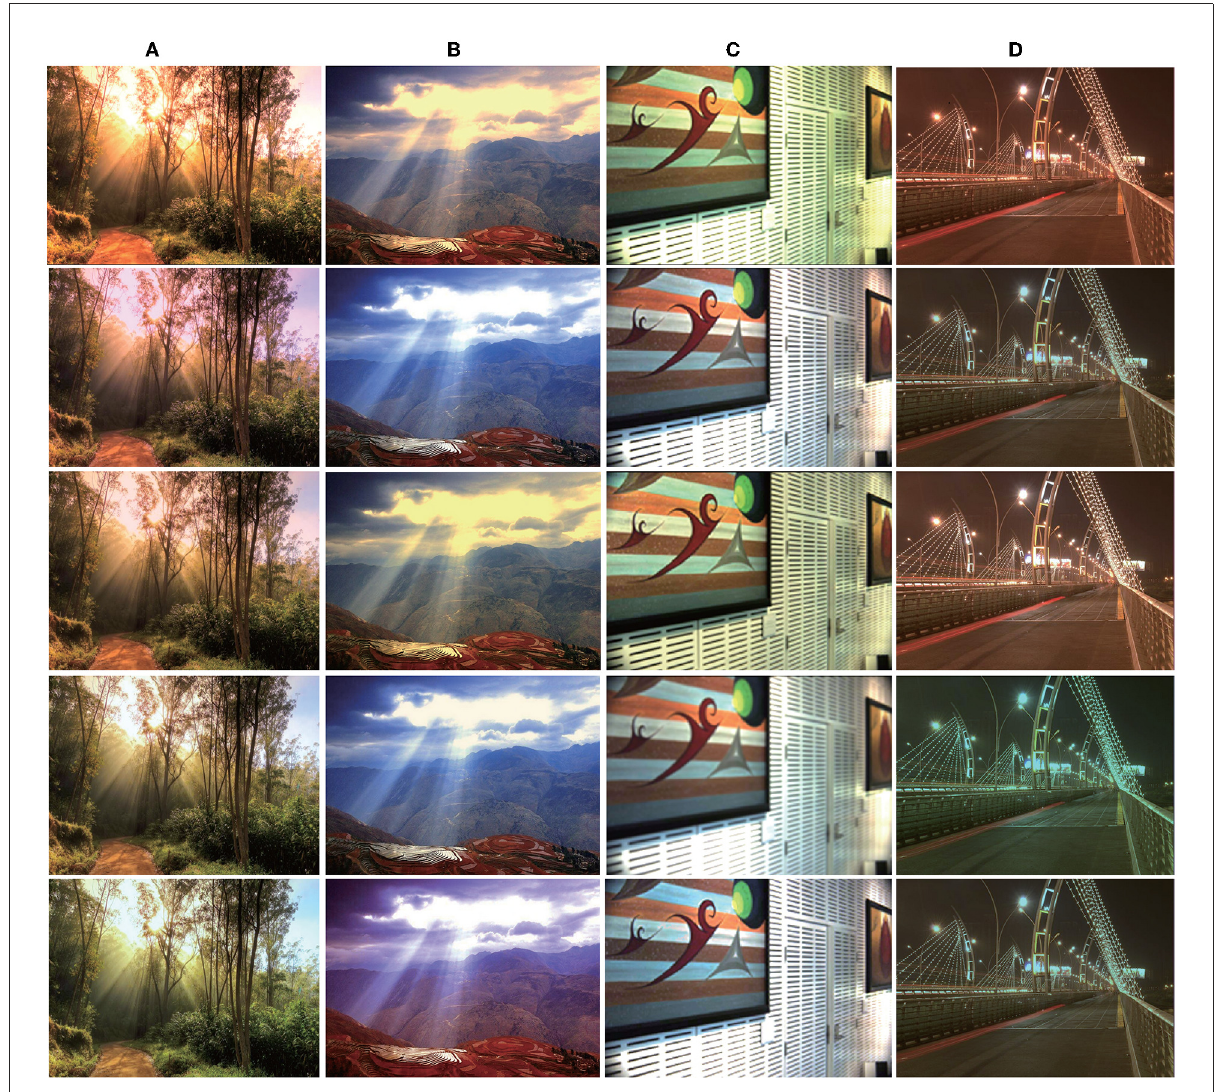
FIGURE5 Qualitative results on natural scenes. The images in columns 1, 2, and 4 are taken from Baidu.com, available at: http://mms2.baidu.com/it/u= 3199546478,84333290&fm=253&app=138&f=PNG&fmt=auto&q=75?w=669&h=500, http://mms0.baidu.com/it/u=576667012, 1565892735&fm=253&app=138&f=JPEG&fmt=auto&q=75?w=500&h=331 and http://mms2.baidu.com/it/u=3592193920,2788102915&fm= 253&app=138&f=JPEG&fmt=auto&q=75?w=500&h=329. The image in the third column is from the doctoral thesis (Gao, 2017). For each column, from top to bottom: Original image; (A) Result By GP (Yang et al., 2015); (B) Result By Retinex (Brainard and Wandell, 1986); (C) Result By Zhang ( Zhang et al., 2016); (D) Our